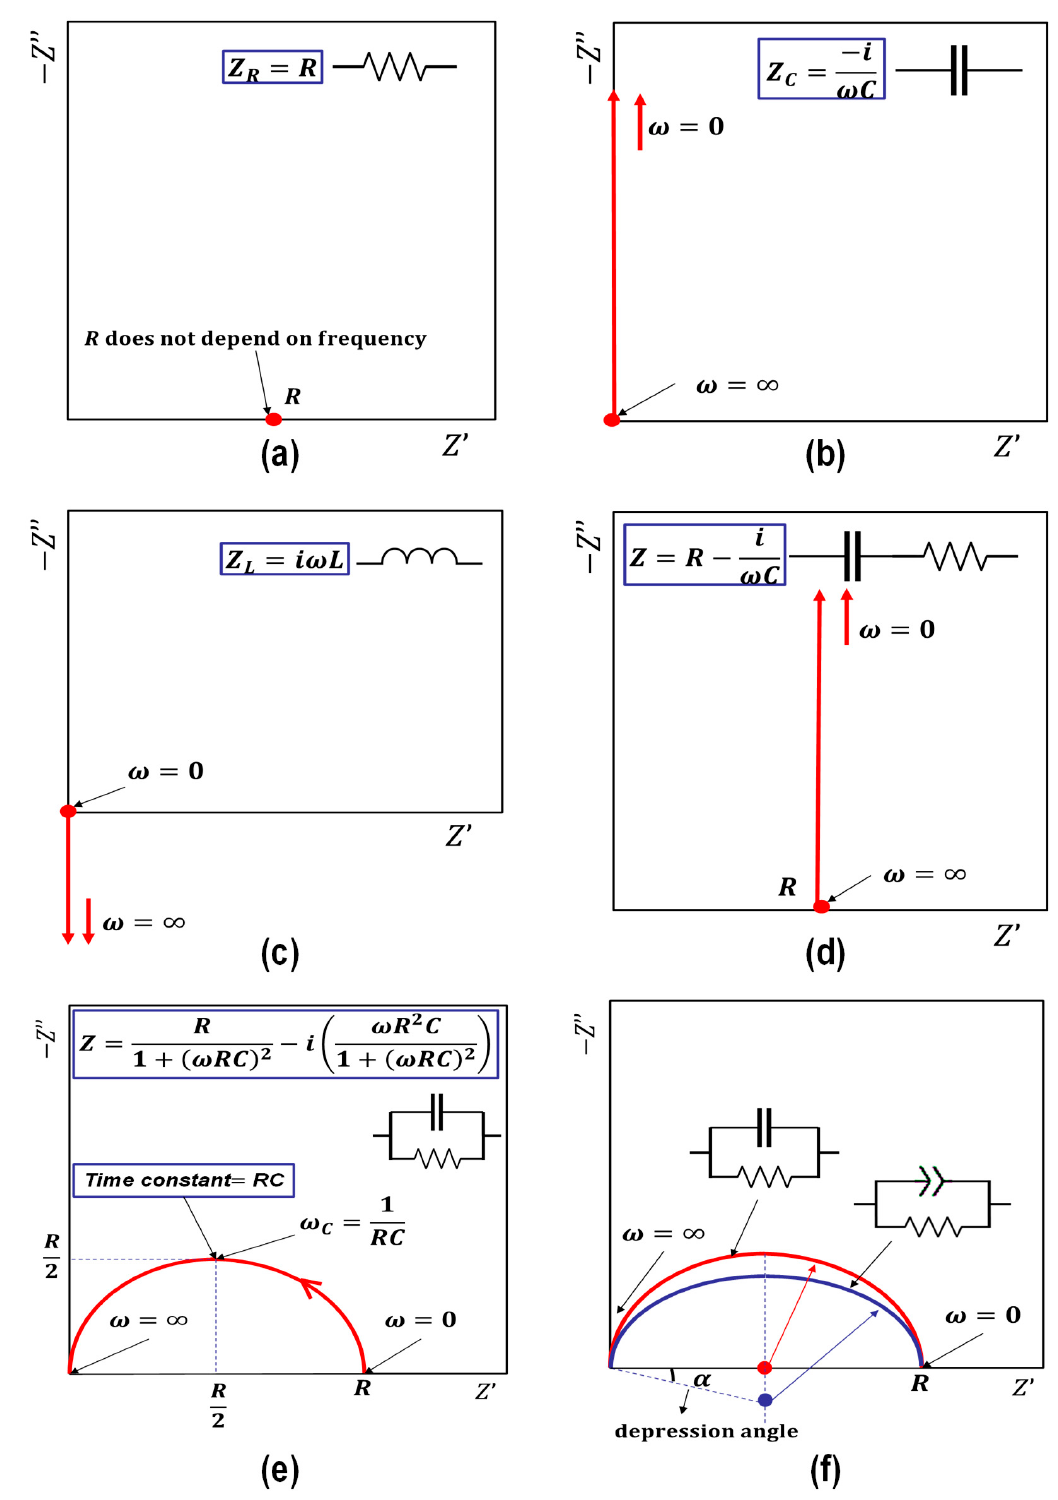
Figure 11. Complex plans (Nyquist plots) of typical ACIS plots for different combinations of a resistor, a capacitor, and an inductor: ( a ) the representation of a resistor; ( b ) the representation of a capacitor; ( c ) the representation of an inductor; ( d ) the representation of a capacitor and a resistor in series; ( e ) the representation of a capacitor and a resistor in parallel; ( f ) the representation of a constant phase element (CPE).